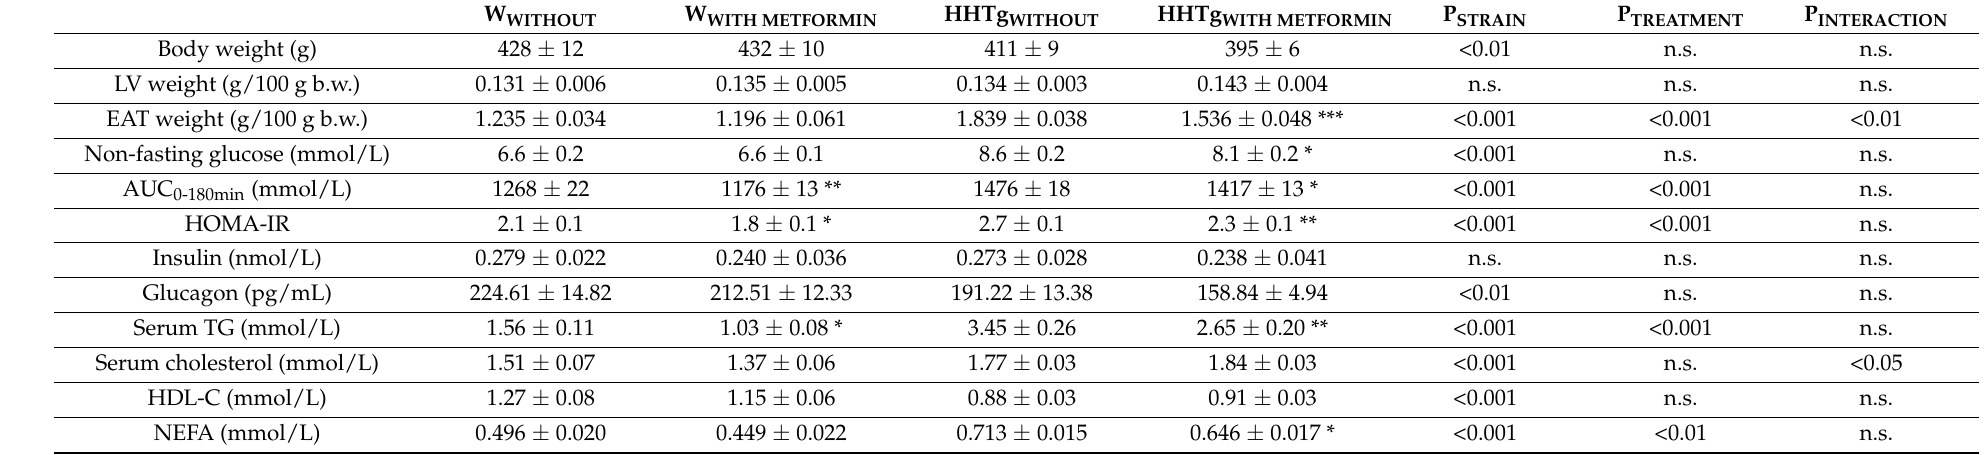
Table 1. Basal metabolic and morphological parameters in Wistar control ( W WITHOUT ) and hereditary hypertriglyceridemic ( HHTg WITHOUT ) rats after metformin administration ( W WITH METFORMIN ), ( HHTg WITH METFORMIN ).